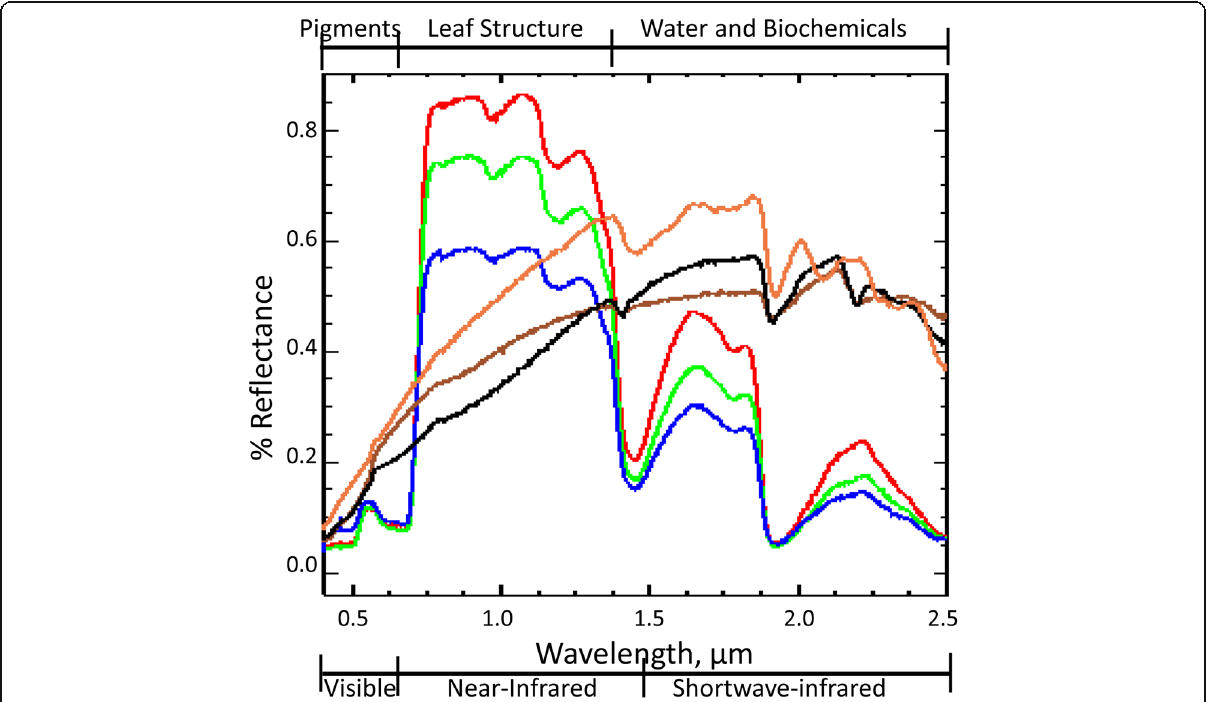
Fig. 1 Spectra of typical green plant and soil materials from the central California Coast Range: red willow ( Salix laevigata leaf, red); valley oak ( Quercus lobata leaf, green); blue oak ( Q. douglasii leaf, blue); dry annual grass leaf, orange; Franciscan formation complex non-serpentine greenstone soil, brown; and Butano sandstone, black. Common leaf biochemicals are shown along the upper edge of the figure indicating regions where absorptions occur. The commonly used names for these regions of the solar spectrum are shown below the wavelength axis. Spectra are from the Environment for Visualization of Images (ENVI) spectral library ver 4.8 and were donated to ENVI and published by Dr. Christopher D. Elvidge 1990. Soil names follow Coleman